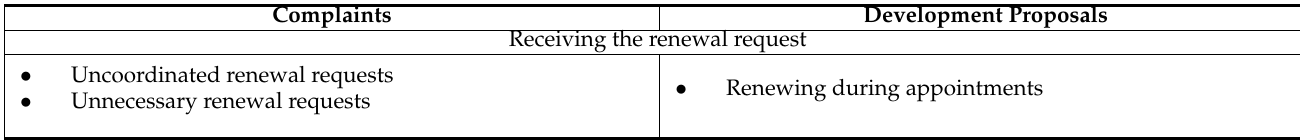
Table 1. The physicians’ complaints and development proposals concerning the renewal process. EPR = electronic patient record